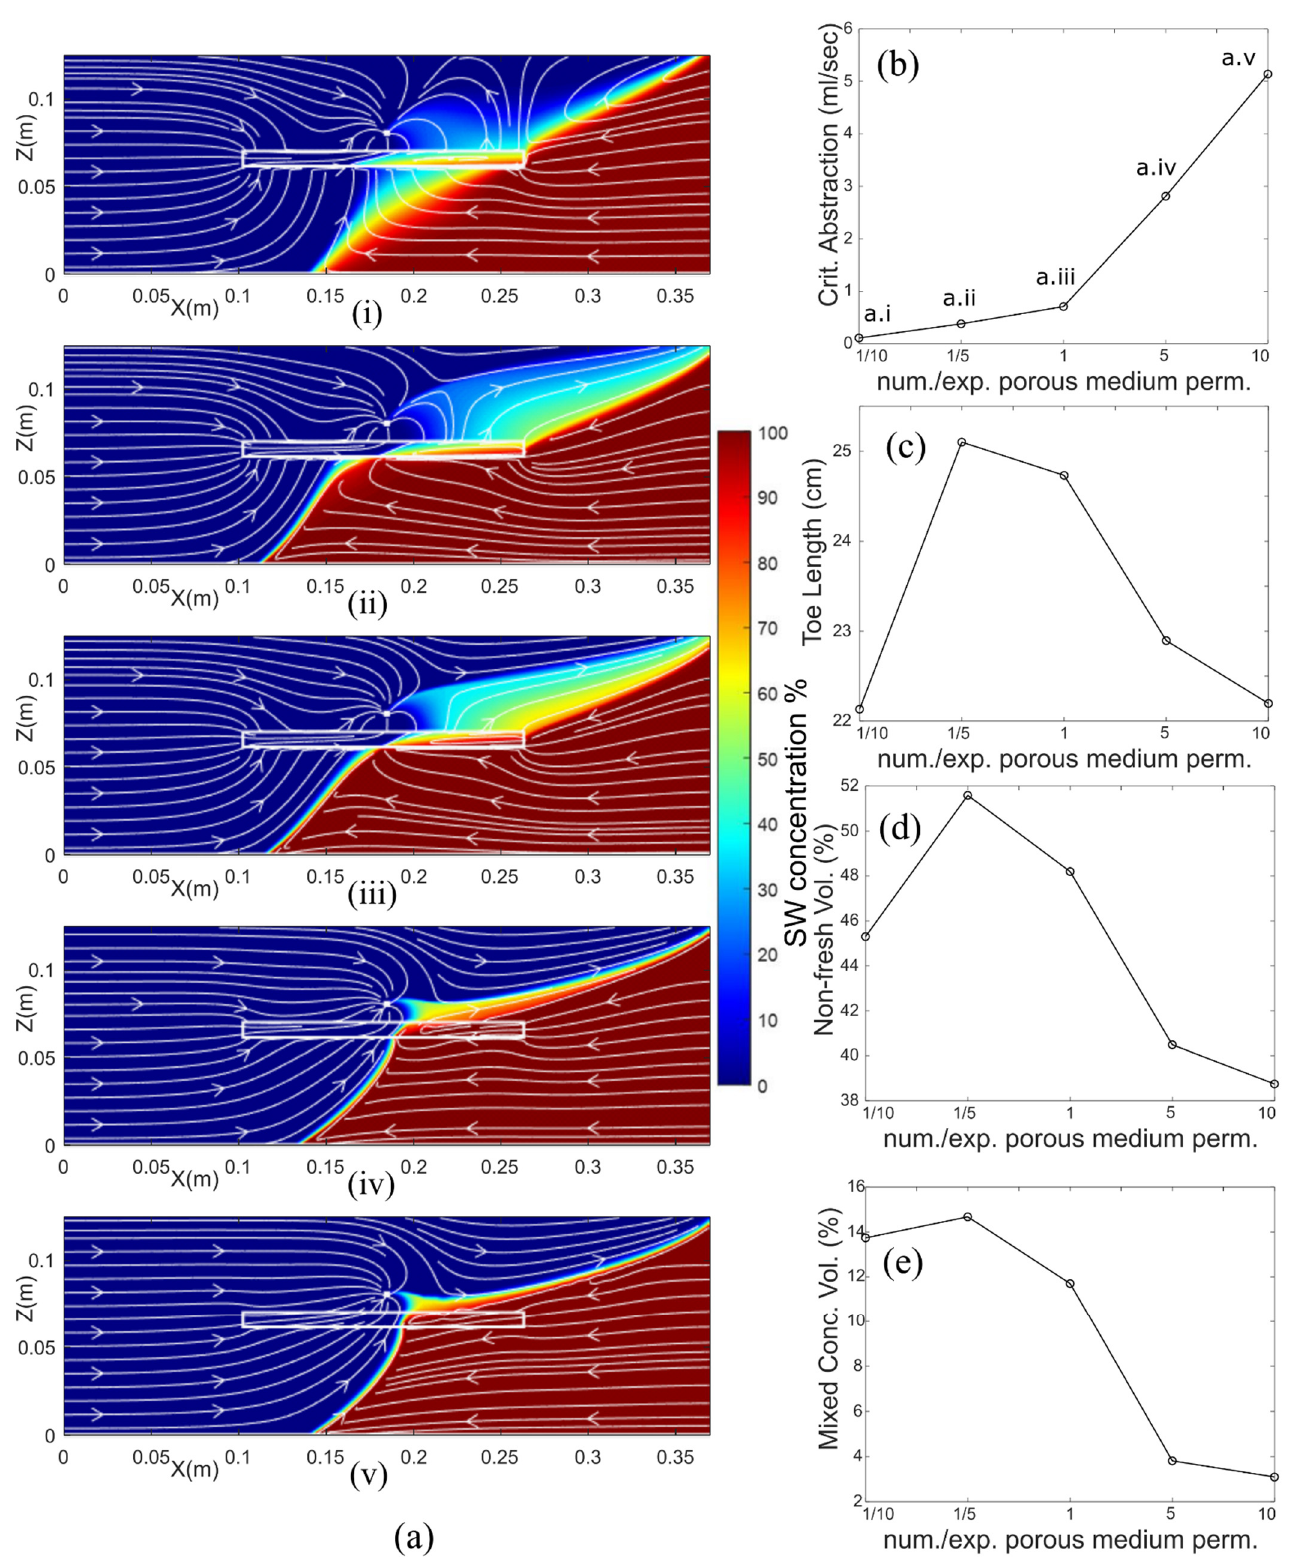
Figure 13. Simulated ( a ) critical SW concentration fields alongside their corresponding values of ( b ) critical abstraction rates, ( c ) toe length, ( d ) non-fresh and ( e ) mixed-concentration volume fractions, demonstrating the impact of the porous medium permeability on the saltwater upconing mechanism.